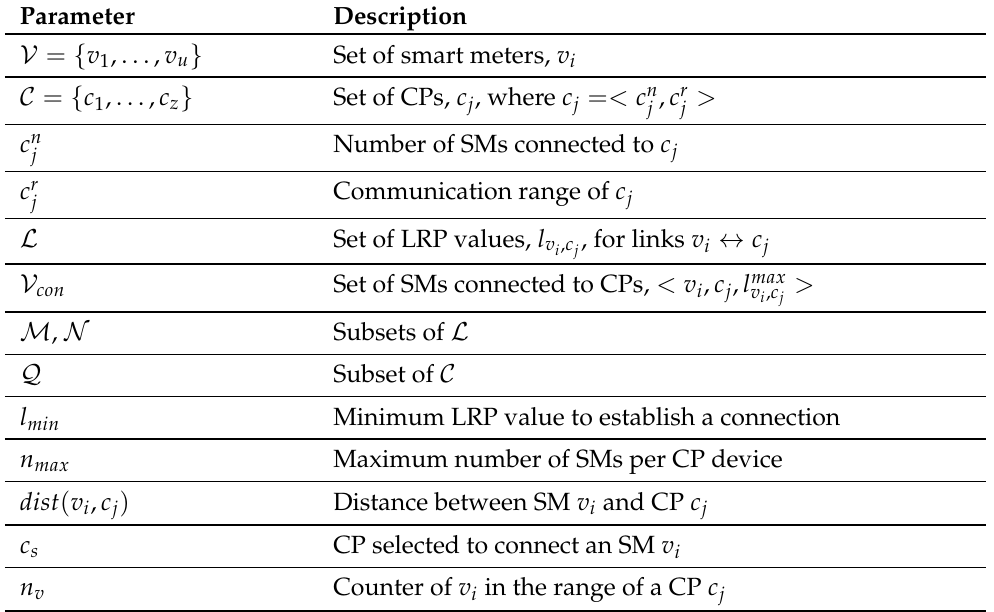
Table 2. Input and output parameters of the algorithms.